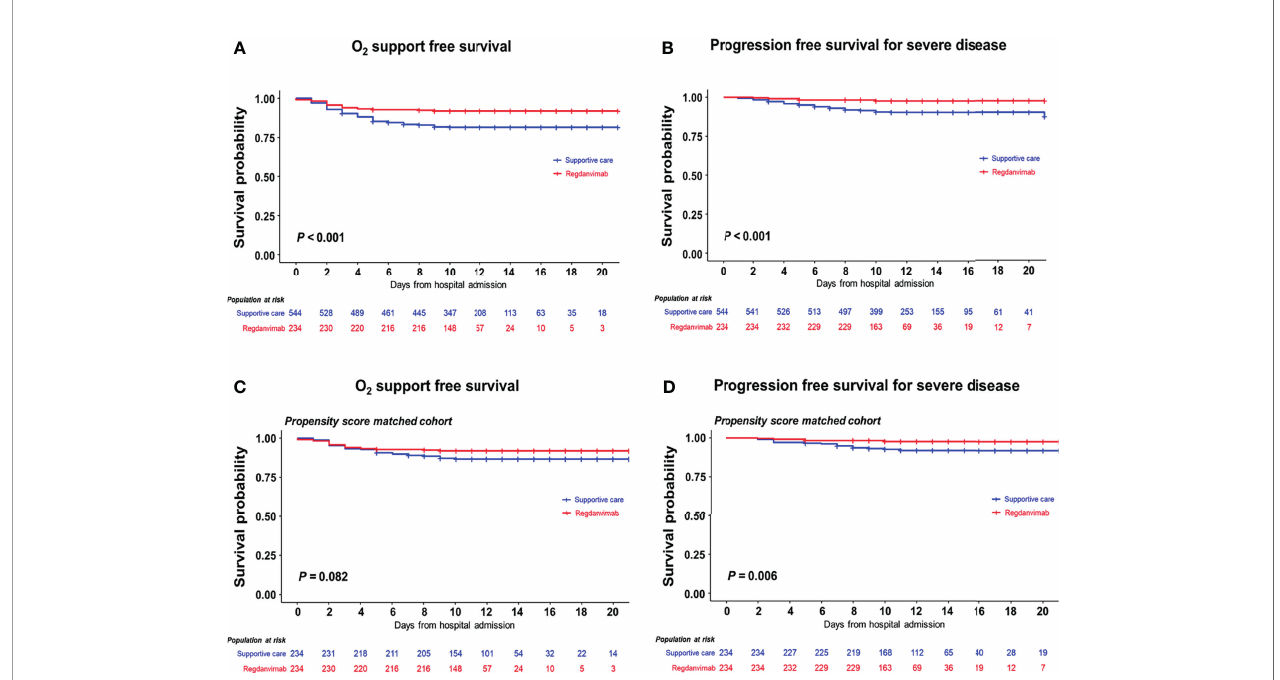
FIGURE 2 | Progression-free survival analysis in the total and propensity score – matched cohorts. The 21-day probabilities for composite outcomes 1 (A) and 2 (B) were evaluated in the total cohort, and the regdanvimab group showed clinical bene fi t for both outcomes. Statistically signi fi cant bene fi ts were also found in the propensity score – matched cohort for composite outcomes 1 (C) and 2 (D)